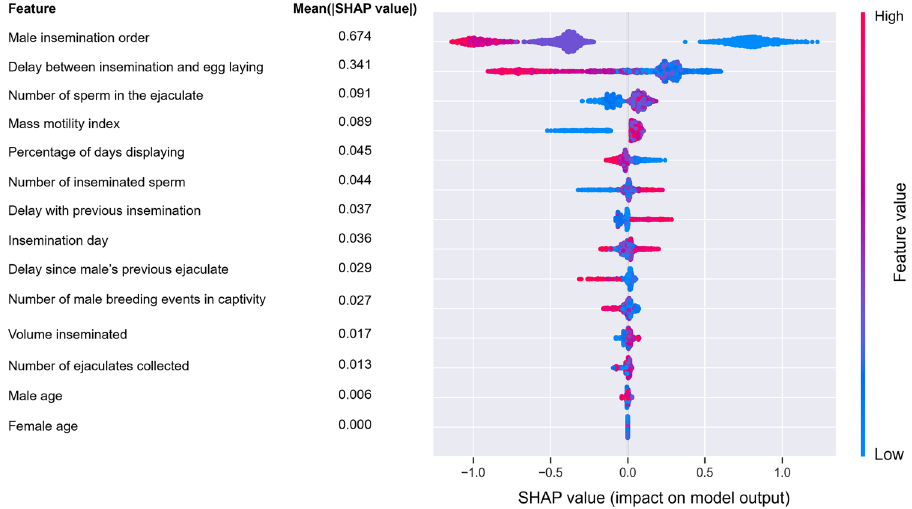
Fig. 1 SHAP summary plot of the 14 predictors of siring success included in the BRT model. The variables on the vertical axis are ranked according to the mean of the absolute SHAP values, indicating their relative global importance as predictors of siring success (higher mean absolute SHAP values corresponding to a larger contribution to the siring success prediction). Dots represent the SHAP values (positive values being indicative of higher siring success, lower values being indicative of higher siring failure) for each insemination ( N = 2226) as a function of the value of the predictor (the redder the color the higher the value of the predictor). Please note that for the insemination order, 1 refers to the last male in the